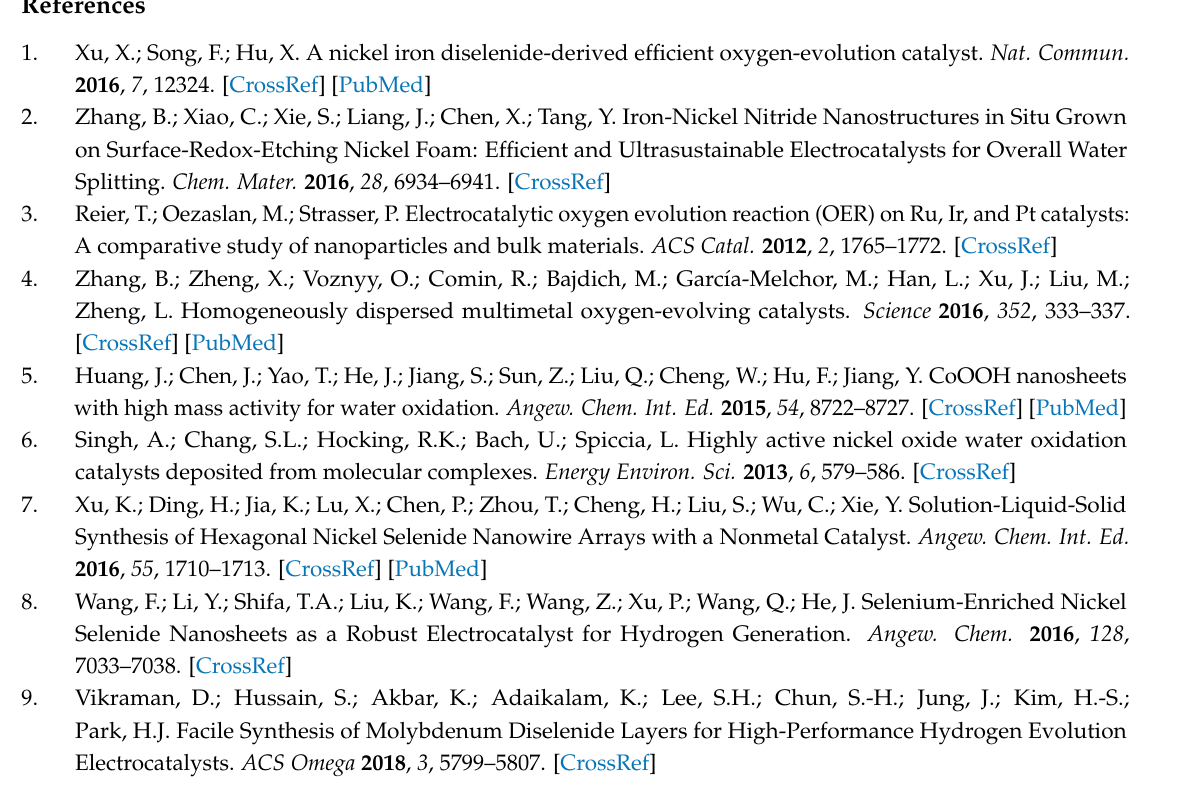
s1, Figure S1: Low magnification of FESEM images. (a) WS 2 (45 min)/NF; (b) WS2/graphene/NF and (c) WS (1 − x ) Se x /graphene/NF. Figure S2: EDS spectrum for WS (1 − x ) Se x /graphene/NF. Figure S3: (a) FESEM image of WS2/graphene/NF and its elemental mapping images of (b) Ni (c) W (d) S and (e) Se elements. Figure S4: (a) FESEM image of WS (1 − x ) Se x /graphene/NF and its elemental mapping images of (b) Ni (c) W (d) C (e) S and (f) Se elements. Figure S5: X-ray photoemission spectroscopy scan for WS 2 (45 min)/graphene/NF. (a) survey scan; (b) C; (c) W; and (d) S binding energies. Figure S6: Linear sweep voltammetry curves of graphene/NF and WS2(30 min.)/NF